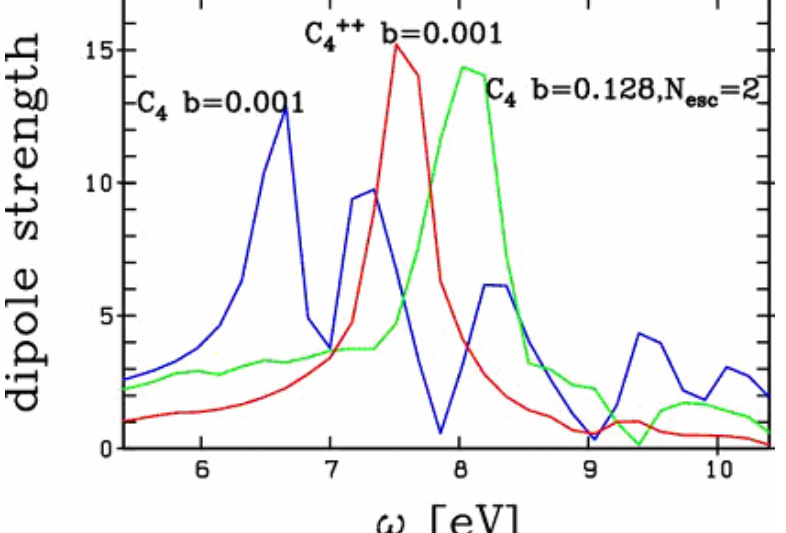
Figure 4. Comparison of the optical responses of C to a non-linear excitation (boost b=0.128) leading 4 to an emission of 2 electrons with the response of C 4++ to linear domain excitation (boost b= 0.001, no emission). The response of C4 to a linear excitation is also given for